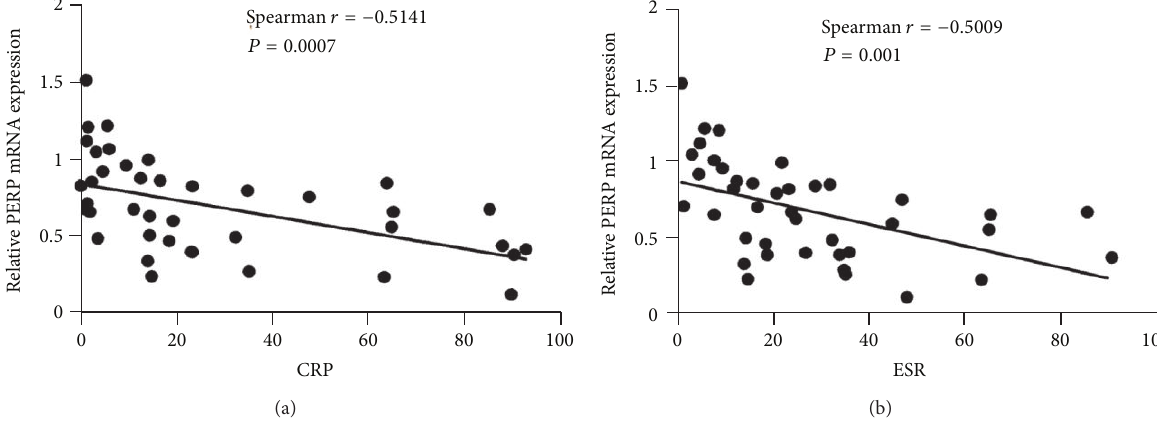
Figure 2: Expression of PERP on PBMCs from RA patients correlates with CRP and ESR. The expression levels of PERP in PBMCs of patients with RA negatively correlate with C-reactive protein (CRP) and erythrocyte sedimentation rate (ESR) ( 𝑃 < 0.01 ; 𝑃 < 0.01 ). 𝑃 < 0.05 deems significantly